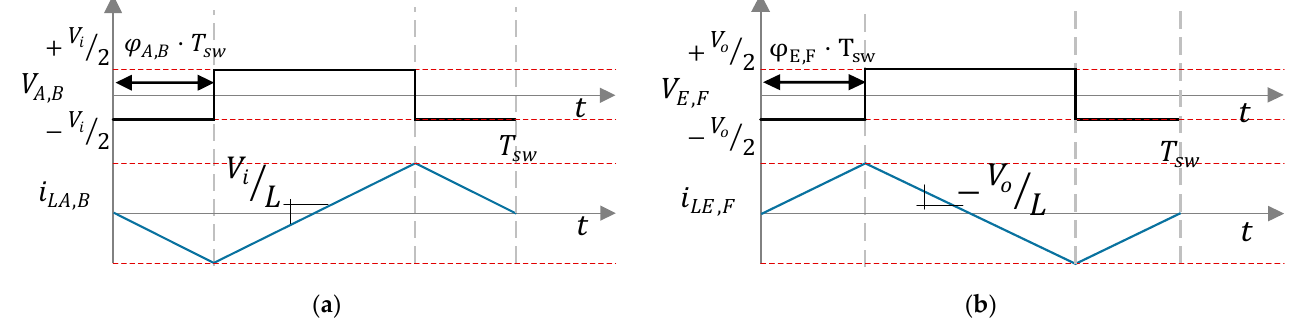
Figure 4. Gate signal and inductor current of each leg: ( a ) primary-side legs; ( b ) secondary-side legs.